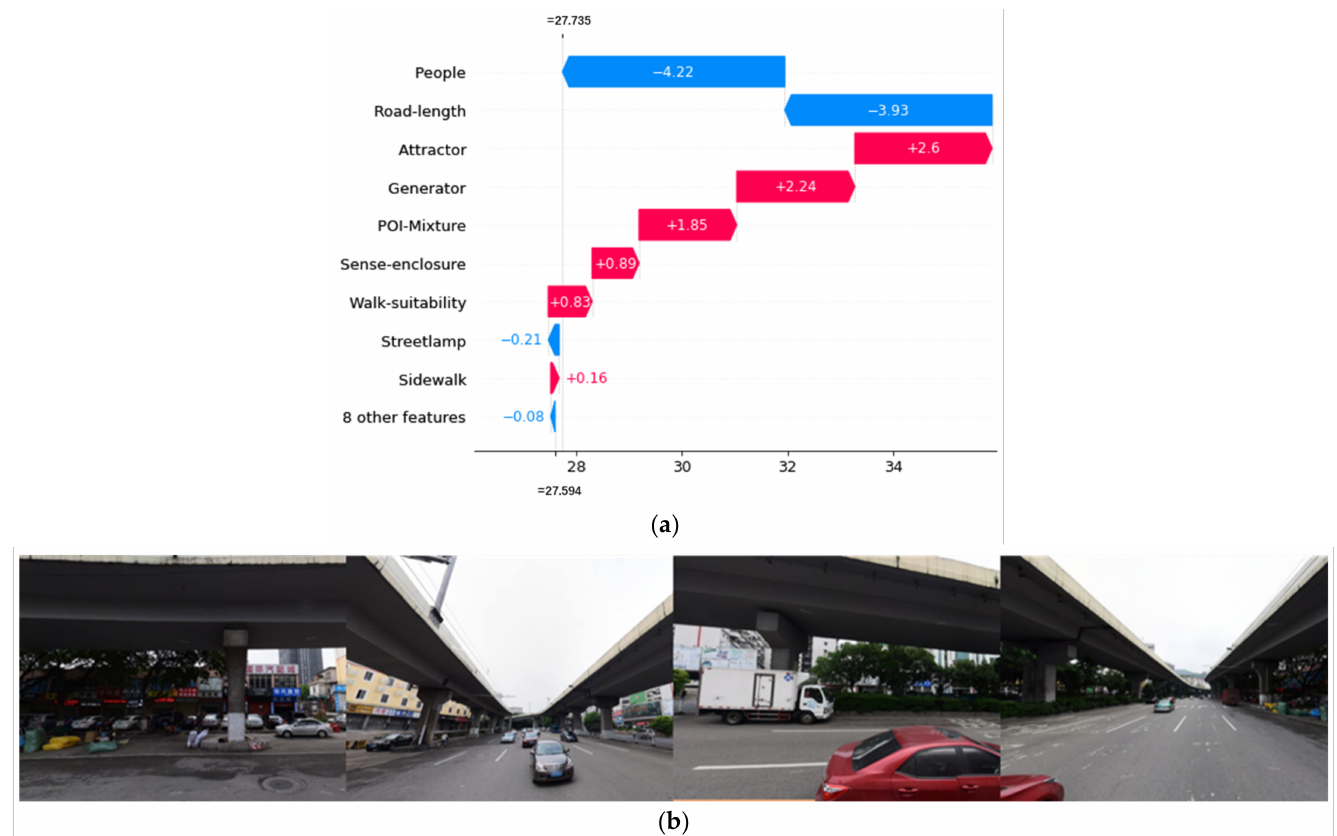
Figure 7. Local SHAP values of the features of the street segment with the mean frequency of street property crime. ( a ) Local SHAP values. ( b ) Examples of street-view